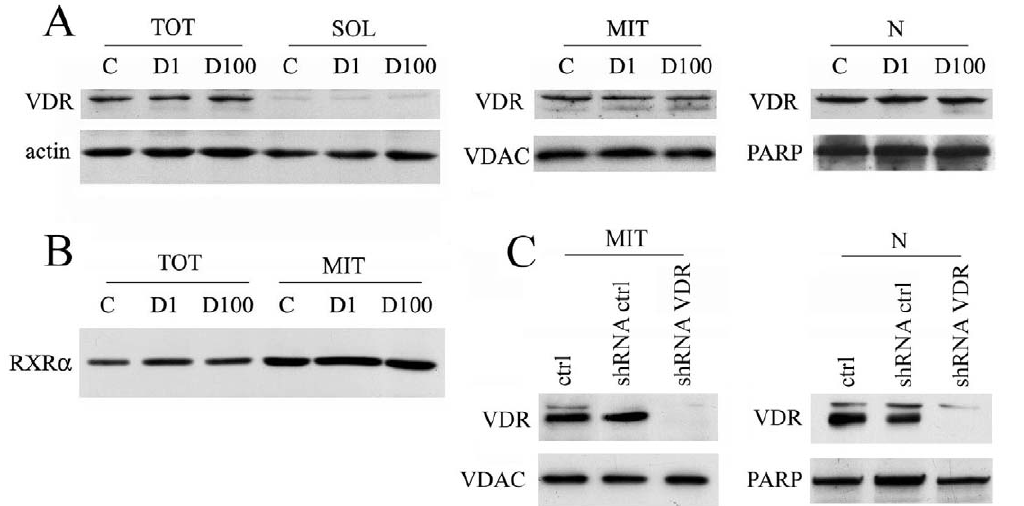
Figure 1. VDR expression and subcellular distribution in HaCaT cells. Cell were incubated for 24 hours alone (control, C) or with 1 or 100 nM 1,25D3 (D1 or D100) and harvested. (A) After subcellular fractionation procedures 50 m g of proteins from total extracts (TOT) and soluble fraction (SOL), and 10 m g of proteins from mitochondria (MIT) and nuclear extracts (N) were separated by SDS-PAGE and analysed by western blotting for VDR expression. Equal loading and quality of samples was confirmed by reprobing the membranes with antibodies anti actin, VDAC (mitochondrial marker) and PARP (nuclear marker). (B) Same amount of total extracts and mitochondrial fractions were analysed by western blotting for RXR a expression. (C) 10 m g of proteins from mitochondria (MIT) and nuclear extracts (N) of untreated cells (ctrl) or cells infected with shRNA control and shRNA anti-VDR were analysed by western blotting for VDR expression and afterwards for loading uniformity.